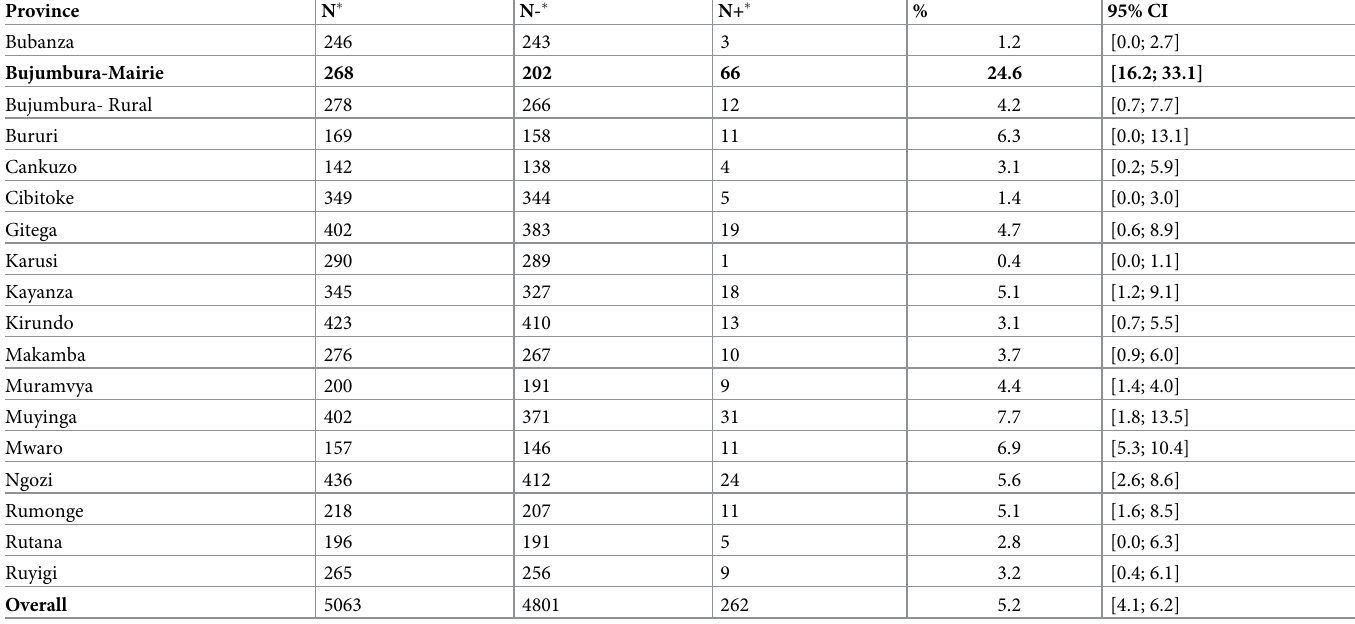
Table 2. Distribution of antenatal care prevalence by